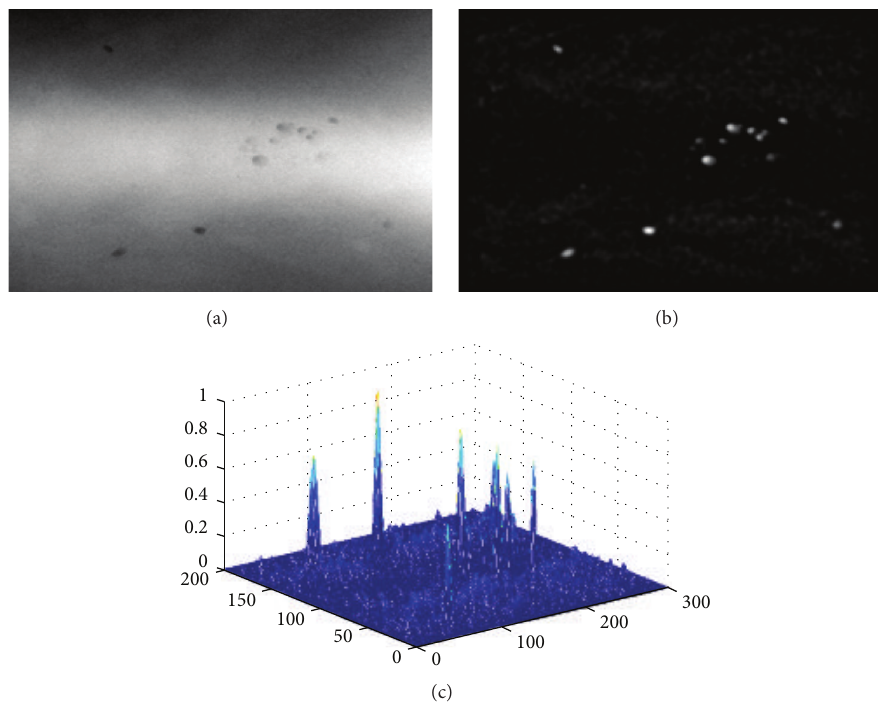
Figure 3: Example of off-center saliency map: (a) ROI radiography weld image, (b) off-center saliency map 𝑆(𝑥,𝑦) , and (c) surface plot of off-center saliency